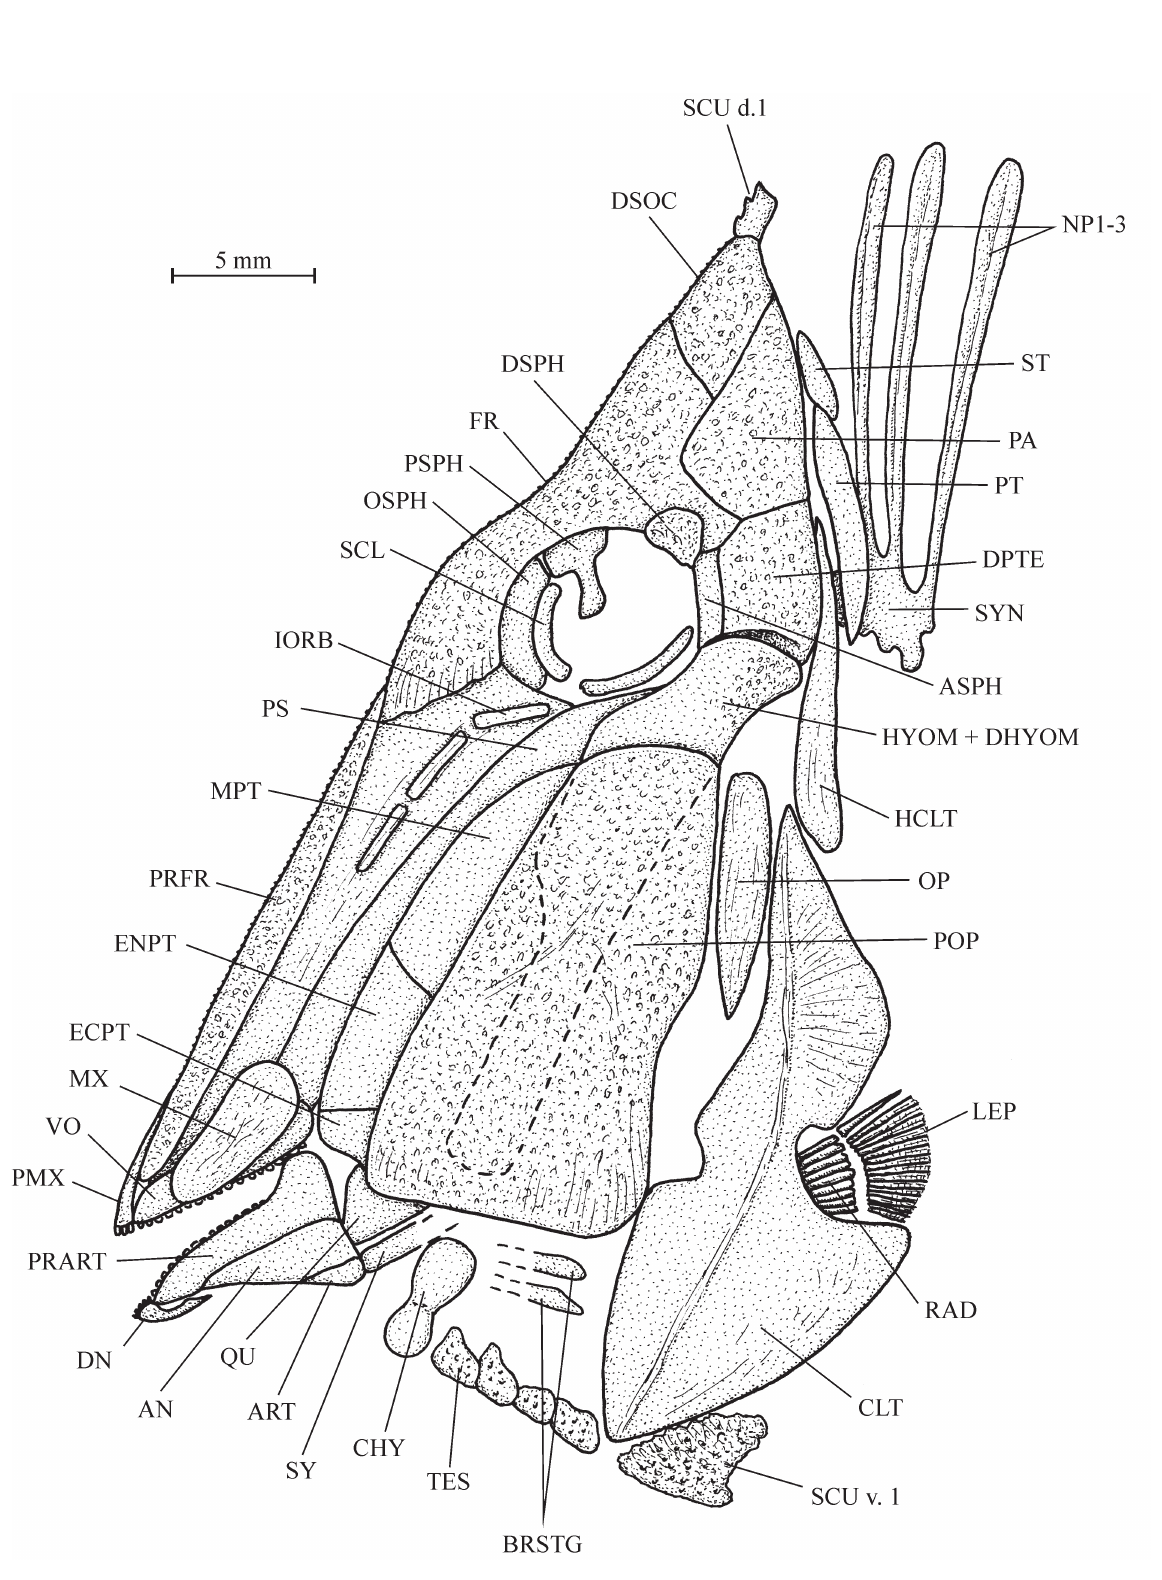
Fig. 10. Acrorhinichthys poyatoi gen. et sp. nov. Reconstruction of the skull and the shoulder girdle based on the three specimens. The scale refers to the holotype CLC